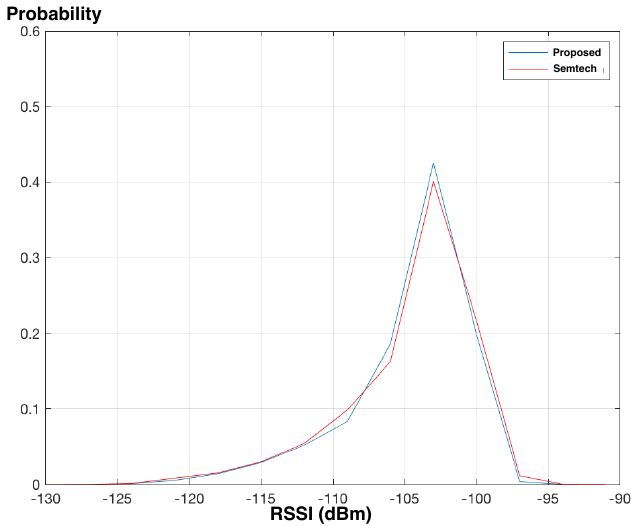
Figure 9. The PRR distribution in B1